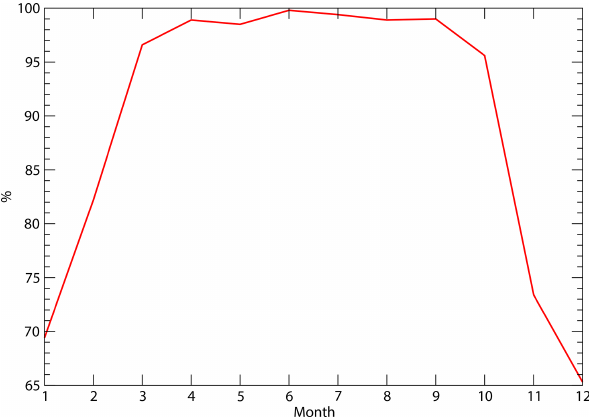
Figure 10. Monthly frequency of cases of an upward vertical gra- dient of PPW, implying downward turbulent moisture